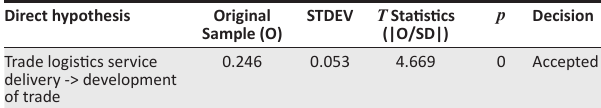
TABLE 4: Structural model assessment. Direct hypothesis Decision Trade logistics service delivery ->